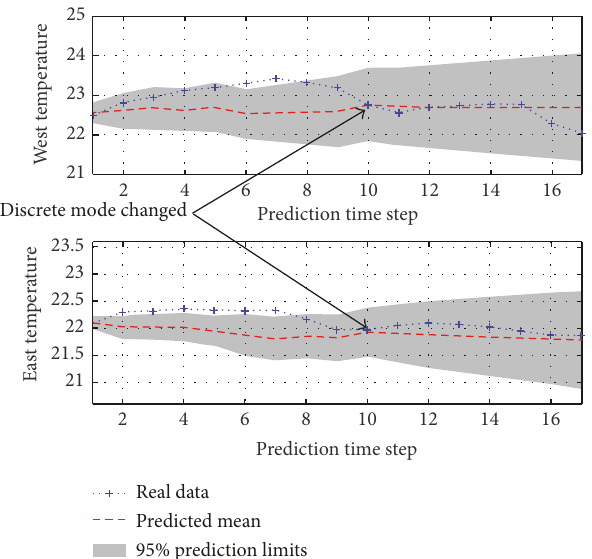
Figure 14: Multistep prediction of zone air temperature for both zones using a typical unimodal GP model.